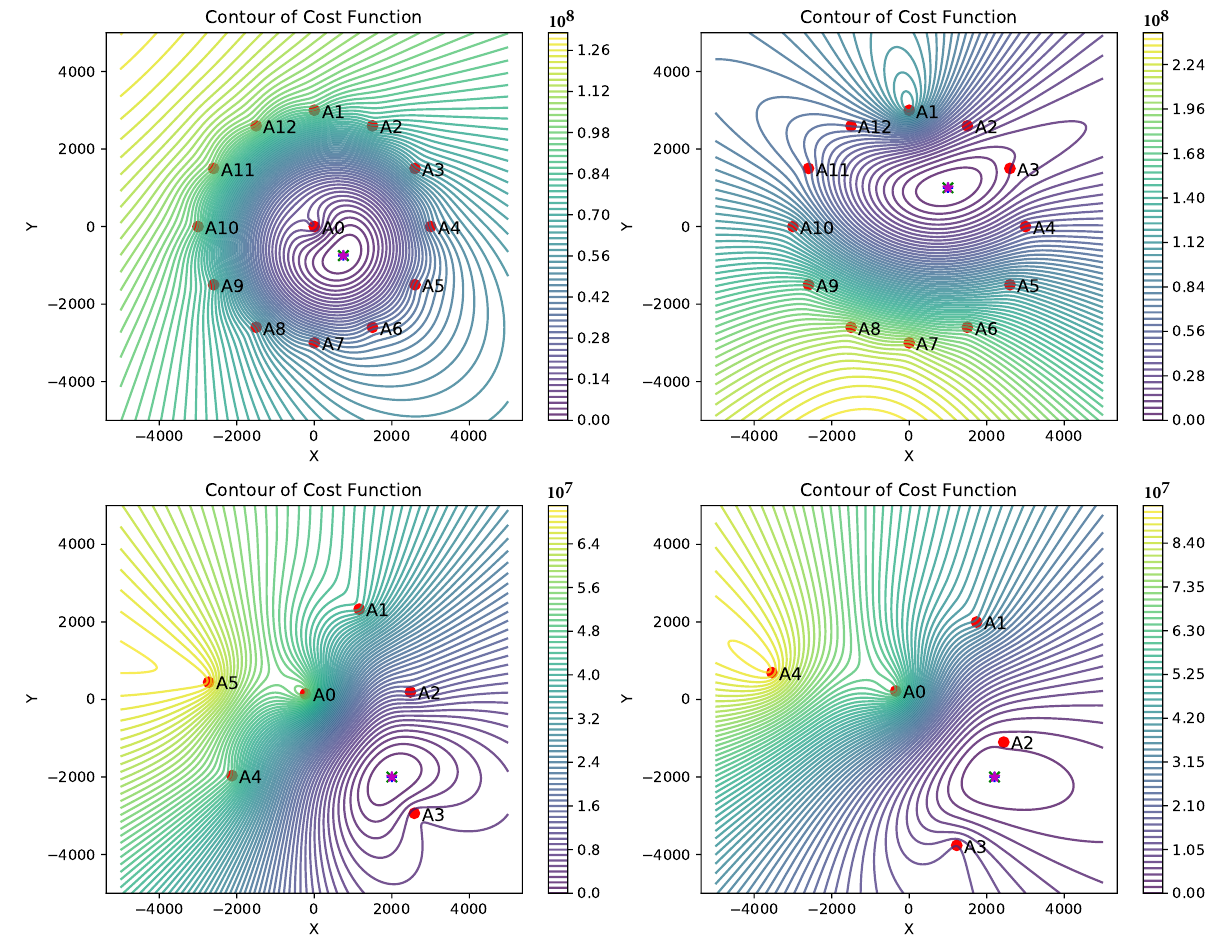
Figure 3. Contour plots of the cost function (5) for different configuration of the anchors and sensor. X and Y are in meters. The plots compares the configurations that are easier to find the correct solution by an iterative solver. A0 represent the lead anchor and other red discs represent assistant anchors. The marker x represents actual location of the sensor and +, and ∗ represent estimated locations by the GN and CF methods, respectively. In all plots the estimated locations by the GN and CF methods are close to the true locations except in the top-left plot where the solution does not exits for CF